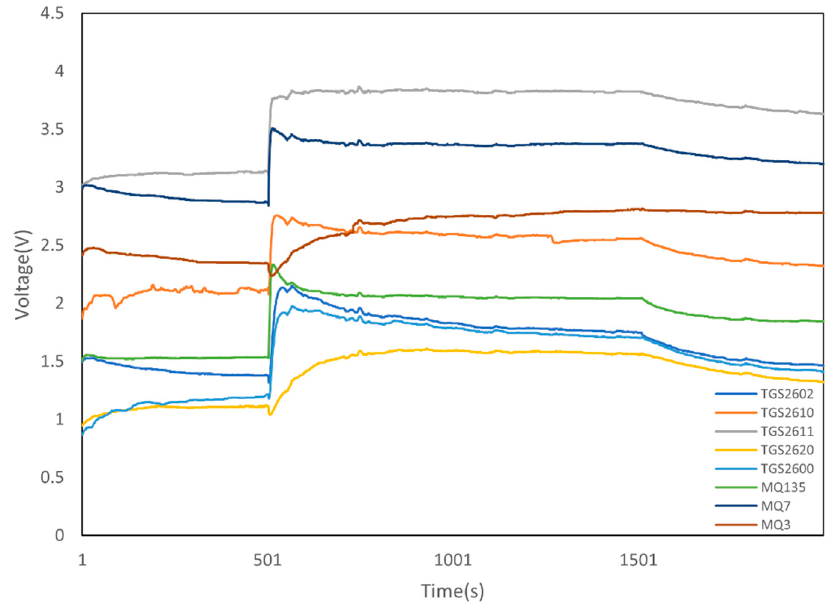
Figure 4. An example of data extraction from our e ‐ nose (8 sensors) outputs.